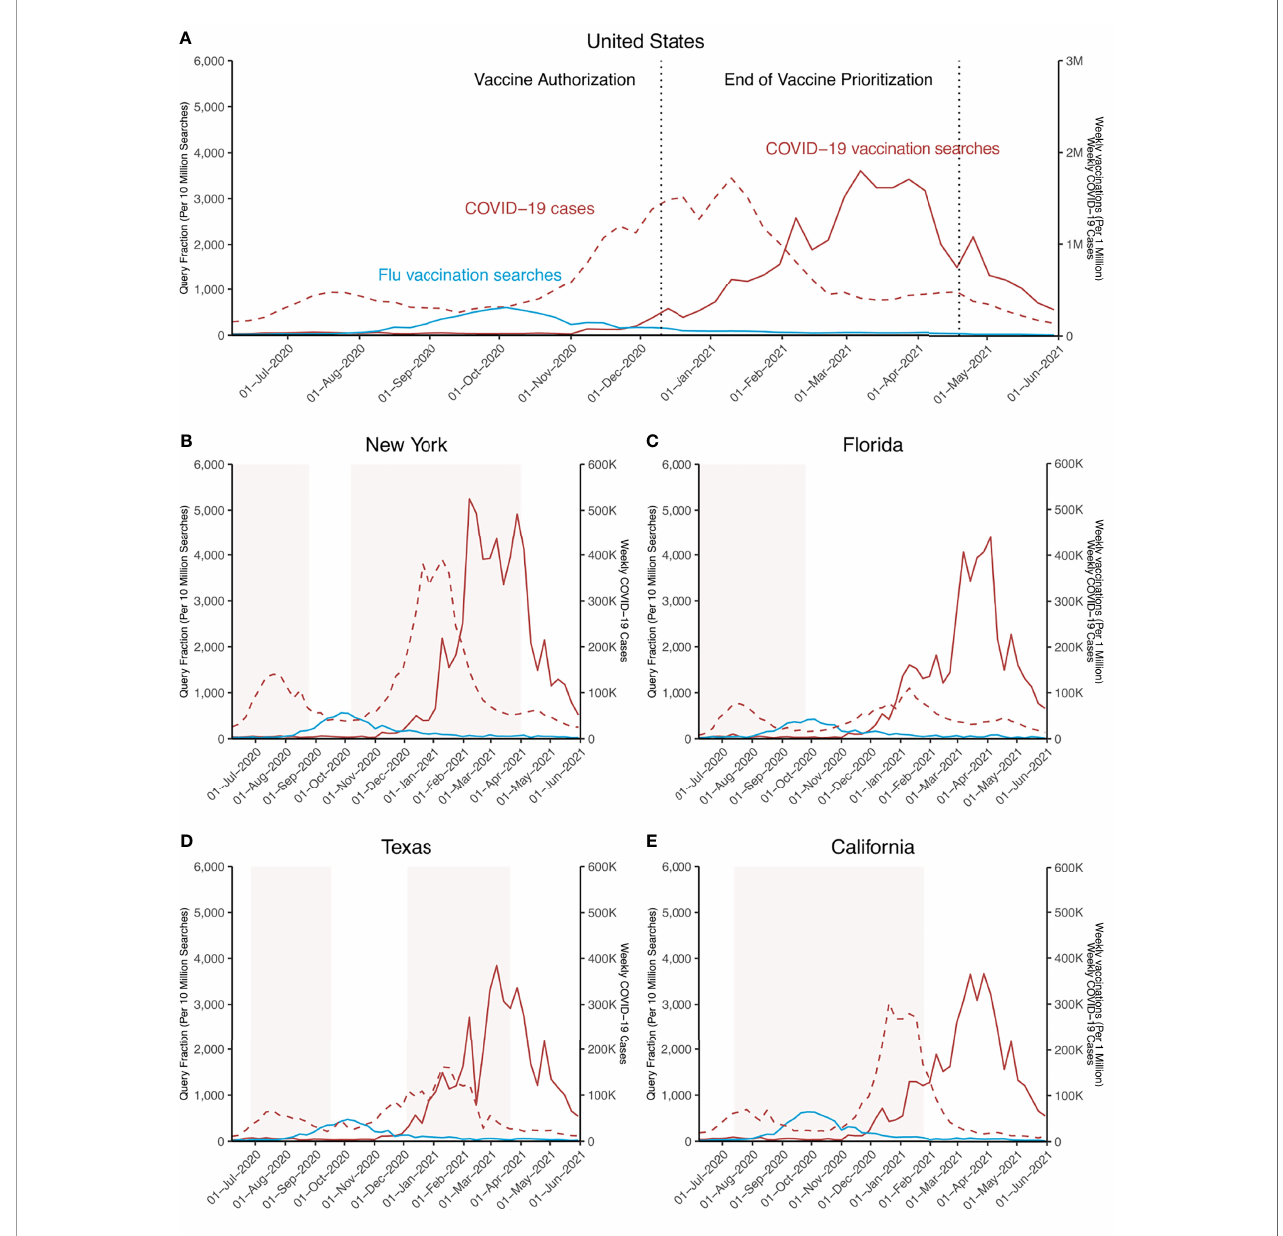
FIGURE 3 | Search Trends for top 10 terms related to COVID-19 vaccination and actual vaccinations administered in the US and selected states. Online searches for the top 10 terms related to “ vaccine covid 19 ” from June 1, 2020, to May 31, 2021, are shown. Weekly vaccinations as applied vaccinations per 1 million are depicted for (A) the United Sates (US) between December 20, 2020 – May 31, 2021, and (B – E) for indicated US states between January 10 – May 31, 2021. Fill color gradients (light red) represent periods of pandemic-related restrictions: (B) March 20, 2020 – August 25, 2020 and October 7, 2020 - April 1, 2021; (C) April